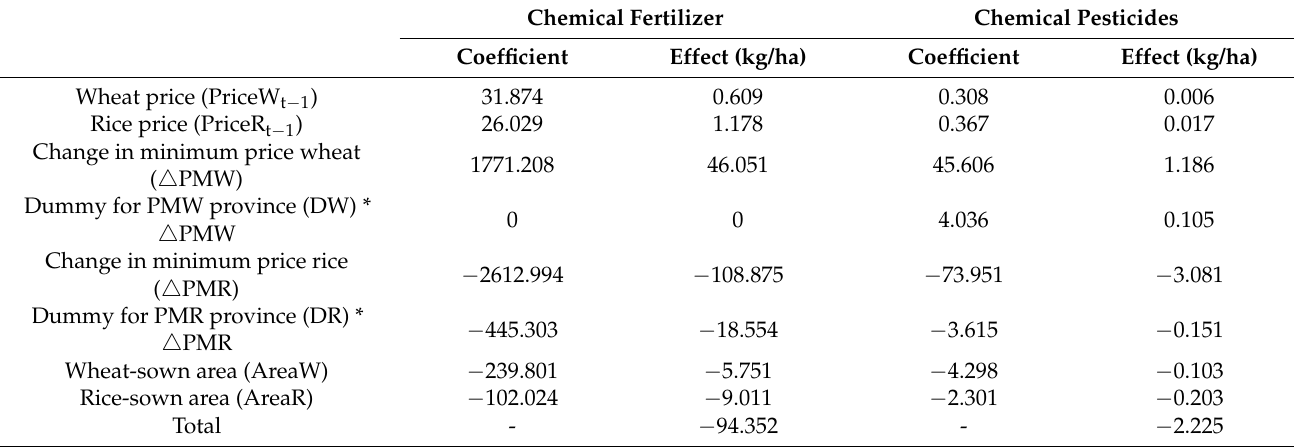
Table 6. Estimated effects for the provinces that implemented the minimum grain procurement price policy until 2010. Chemical Fertilizer Chemical